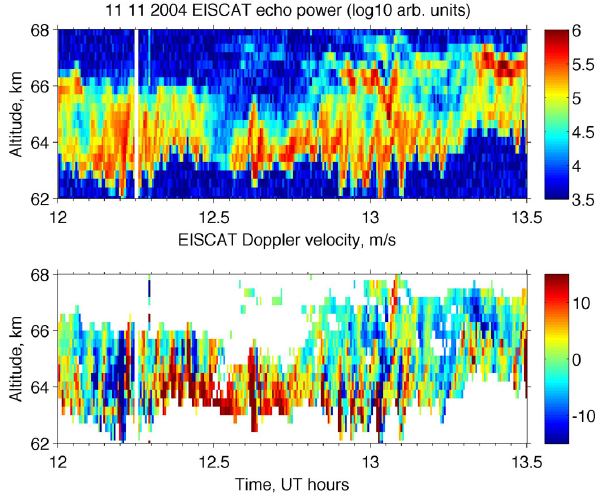
Fig. 1. Time–altitude maps of ESRAD (upper panel) and EISCAT VHF volume reflectivities during the SPE on 10–12 Novem- ber 2004.